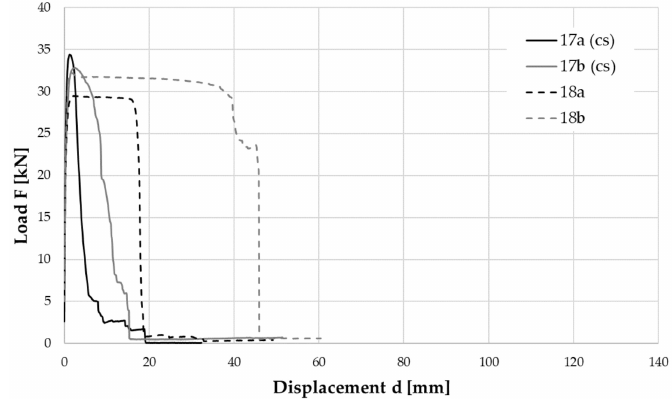
Figure 19. Tensile load-displacement response curves for samples 14a and 14b, without refreshed elastomer layers, and sample 16b, with refreshed elastomer layers.